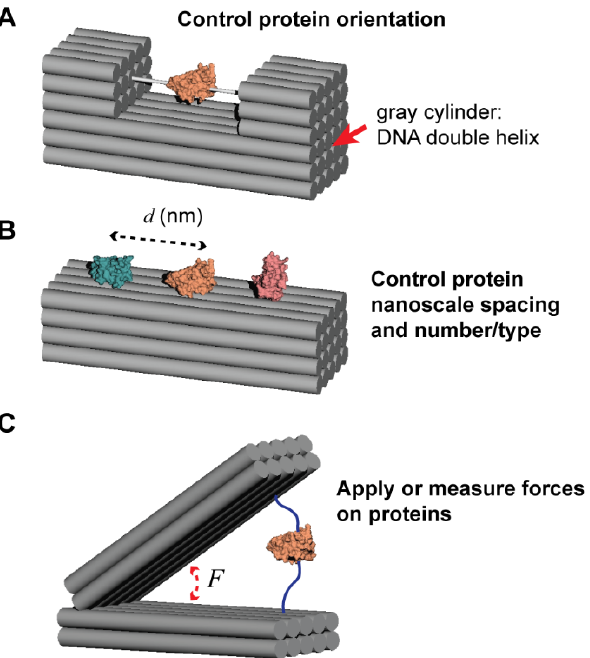
Figure 1. Scope of this Perspective. ( A ) Controlling protein orientation by attachment to rigid DNA nanostructures that enables visualization by another technique (e.g., cryo-EM). ( B ) Controlling protein spacing (at the nanometer scale) and the number or type of protein attached. ( C ) Using a DNA nanostructure to either apply a force to, or measure the force exerted by, an attached protein.